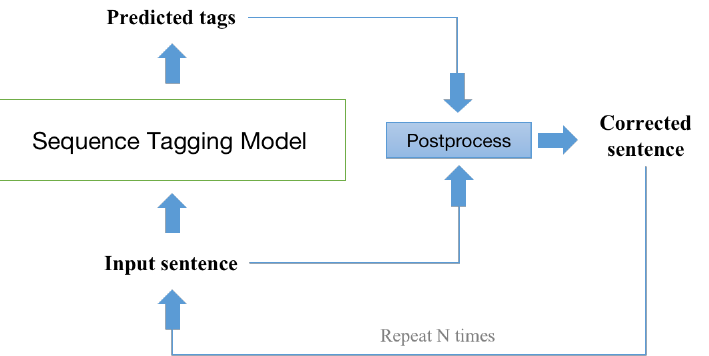
Figure 4. The structure of iterative inference.The corrected sentence, which results from the processing of the input sentence and the predicted tags, is used as the input sentence for the next round.